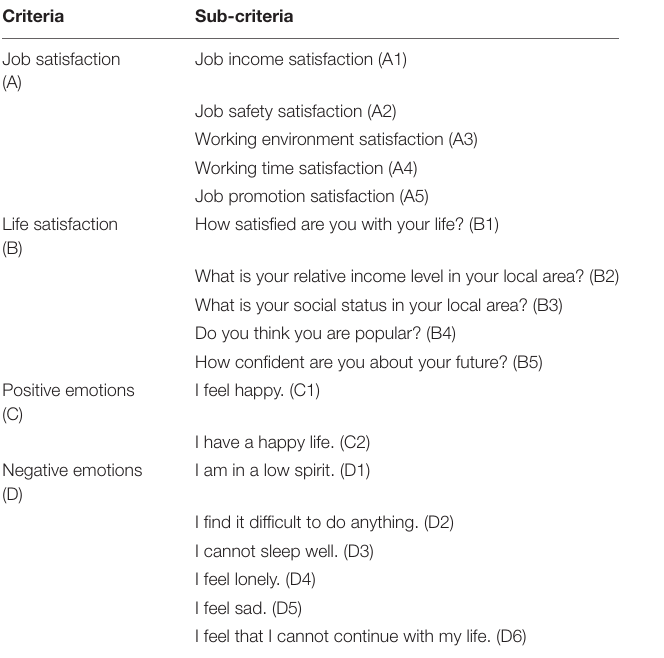
TABLE 1 | The preliminary criteria system of employee well-being based on CFPS. Criteria